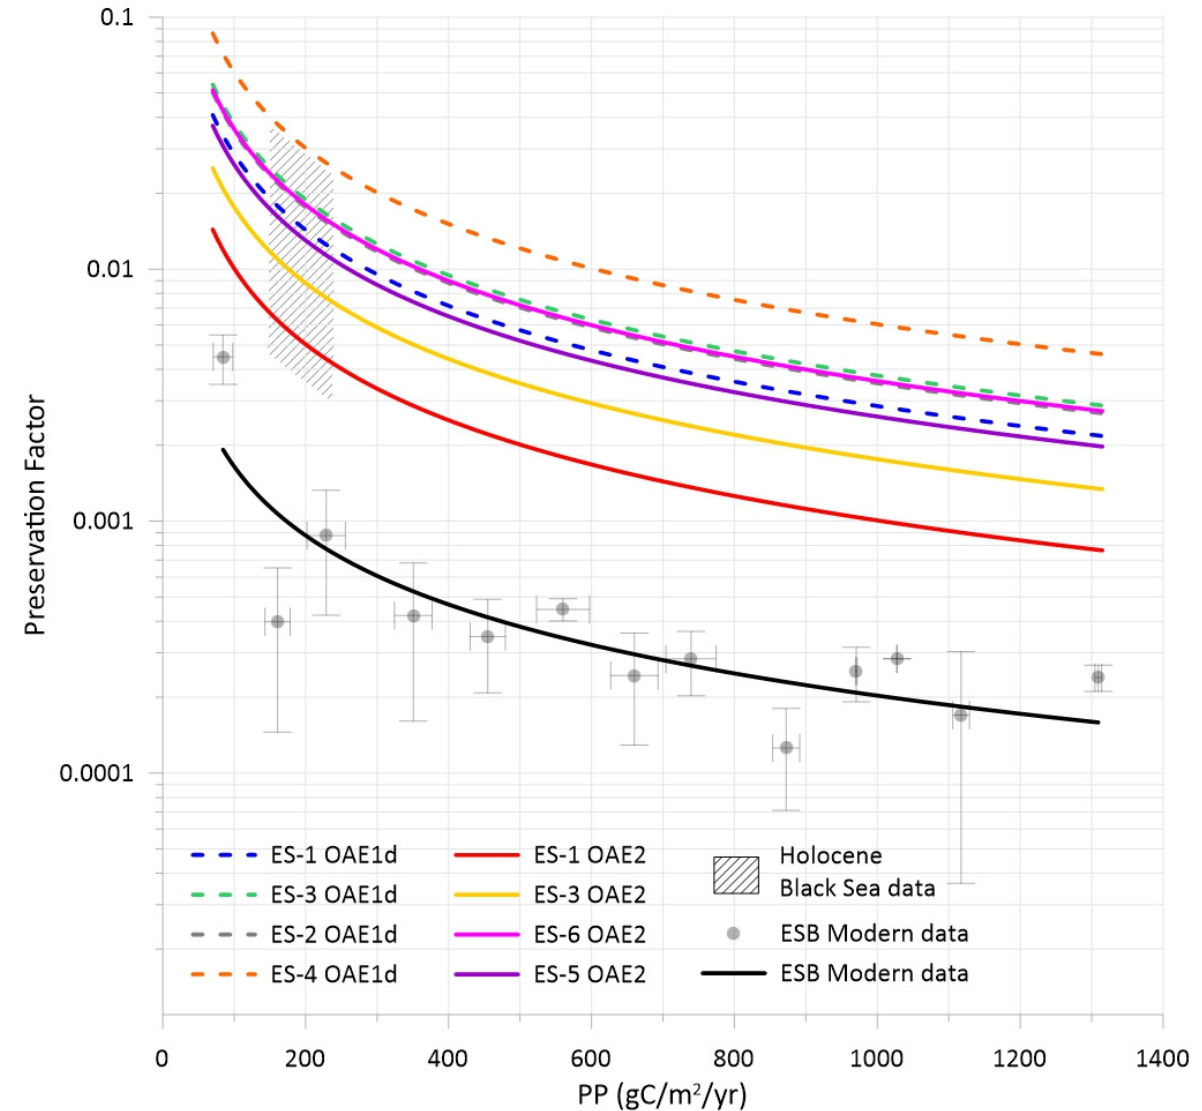
Figure 4. Preservation factors (fraction) for a range of primary productivities (PP) (gC/m 2 /yr). Preser- vation factors were calculated from modern data (productivity data were binned in 100 gC/m 2 /yr intervals) from the Esp í rito Santos Basin (ESB modern data) derived from the modern dataset pub- lished in [27]; error bars are displayed, and a curve was fitted to the data (black solid line). For the wells located in the ESB, preservation factors were estimated based on the mean organic carbon accumulation rate (OCAR) for each oceanic anoxic event (OAE1d and OAE2) and a variable PP considering the modern range of PP for the ESB. Solid colored lines show the calculated values for OAE2, and the dashed colored lines show the calculated values for OAE1d. The y -axis is in log-scale. The rectangle with forward slash filling exhibits the values for the Black Sea during the Holocene based on the results from